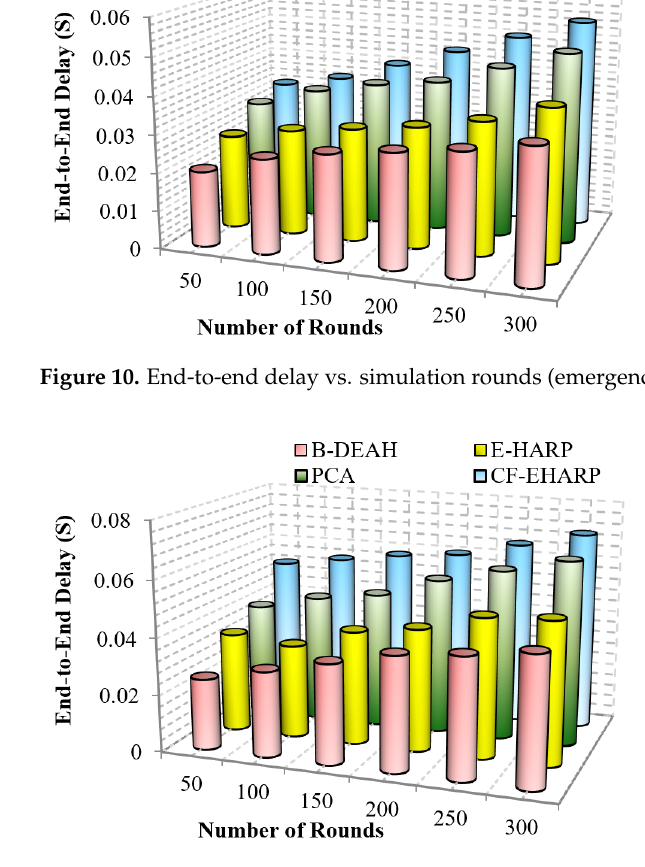
Figure 11. End-to-end delay vs. simulation rounds (periodic